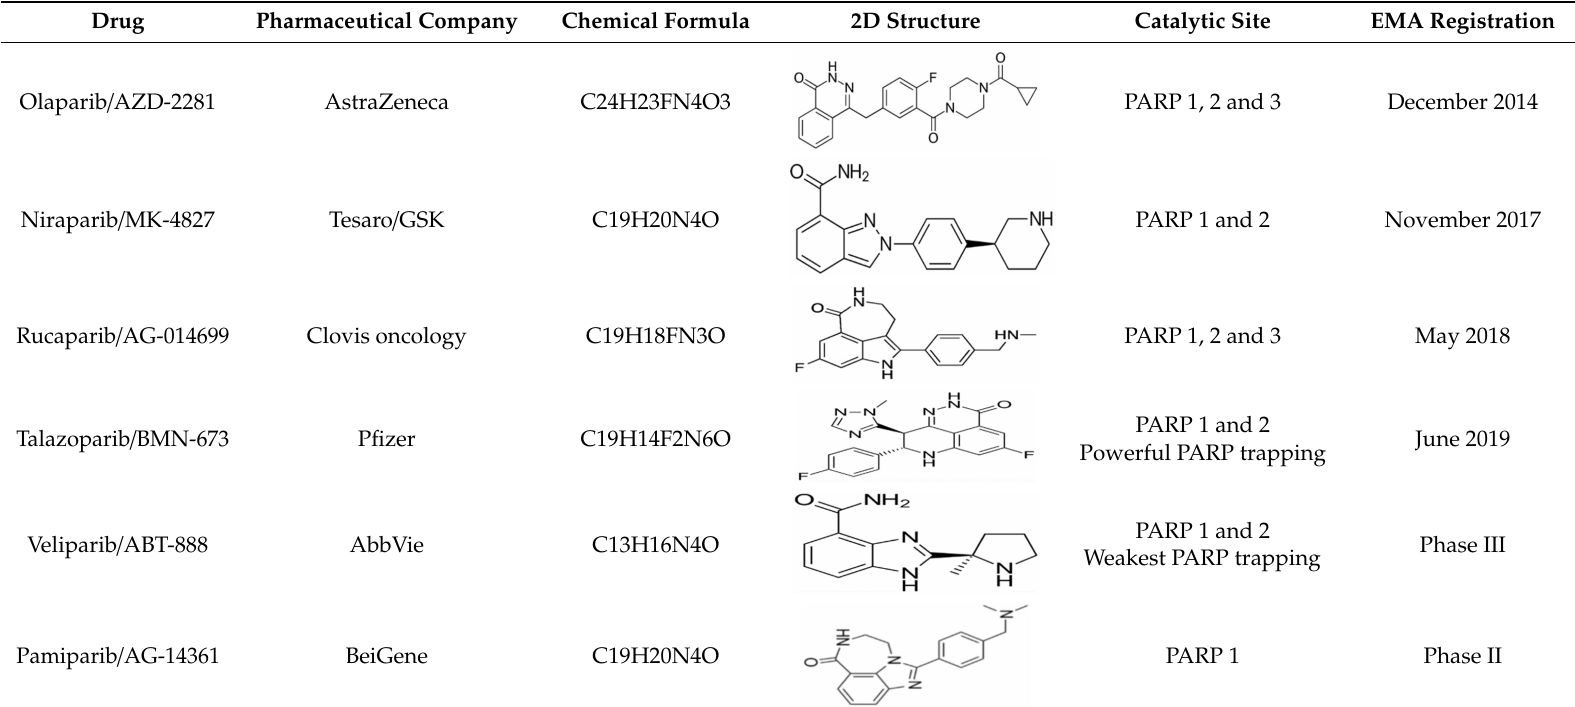
Table 1. Main characteristics of major